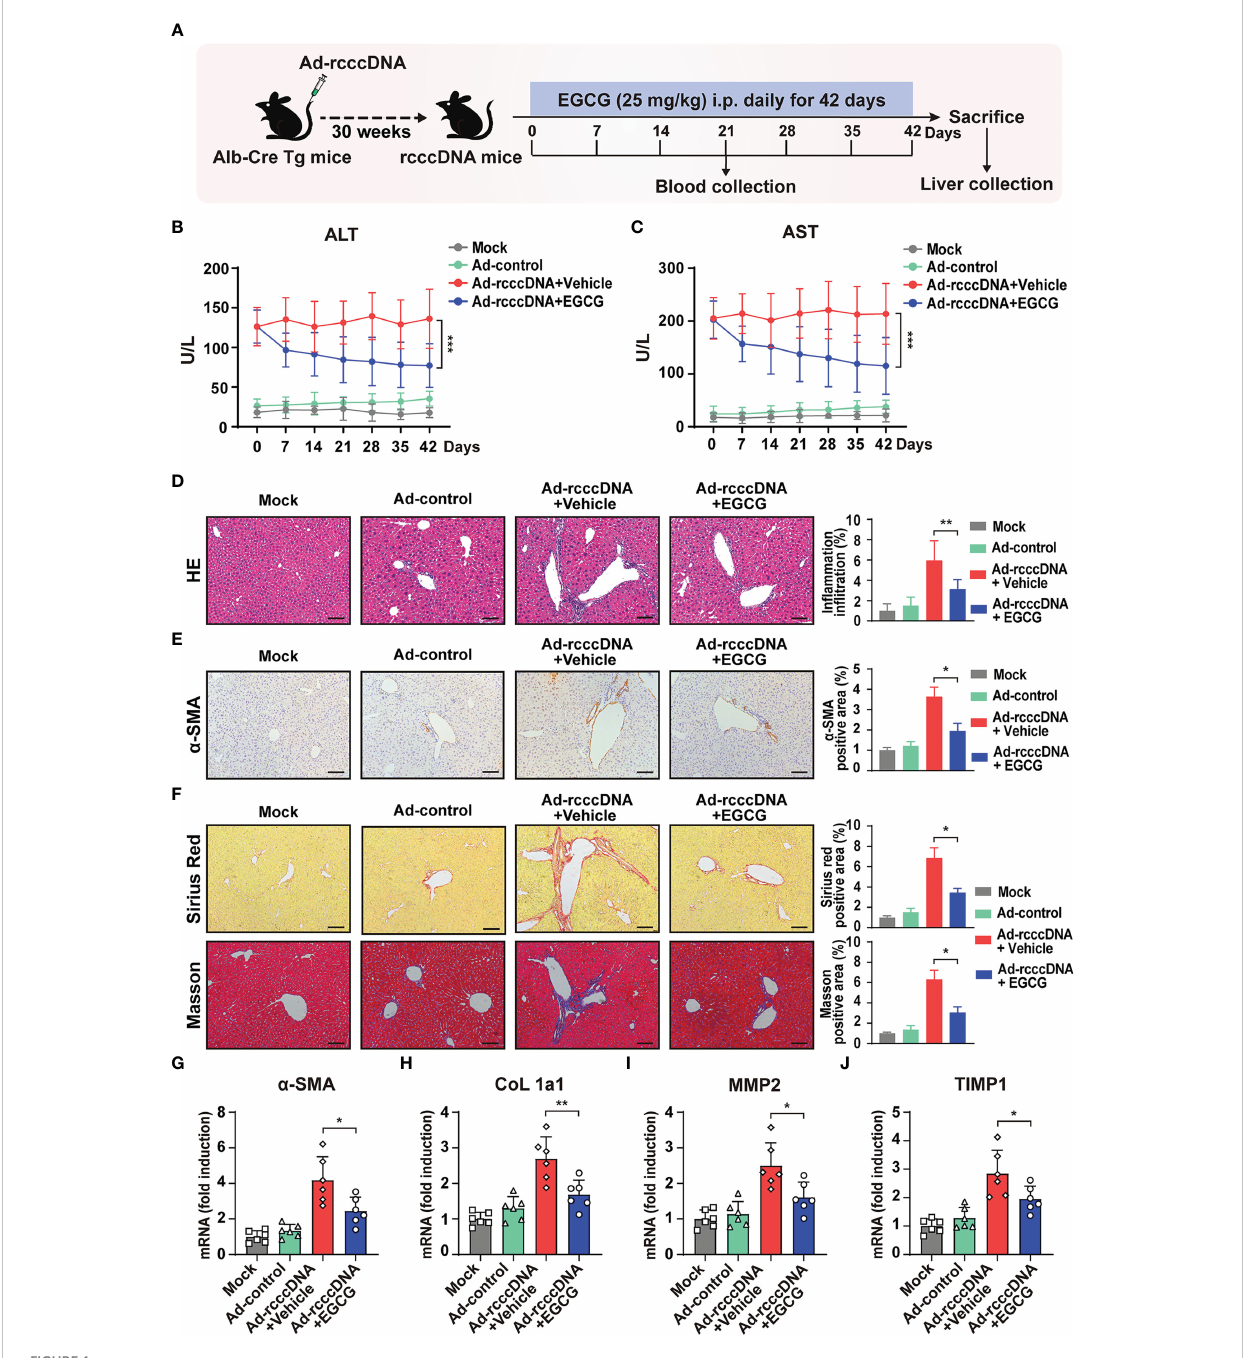
FIGURE 1 EGCG treatment alleviates HBV-induced liver injury and fi brosis. (A) Alb-Cre Tg mice were intravenously injected with Ad/rcccDNA at 1.5 × 10 9 PFU to establish an HBV-induced liver fi brosis mouse model, and the rcccDNA mice were then received an intraperitoneal injection of 25 mg/kg EGCG daily for 42 days ( n = 6 per group). (B, C) Levels of serum ALT and AST were determined by ELISA. (D) Liver in fl ammation in fi ltration was detected by hematoxylin and eosin (H, E) staining. (E, F) a -SMA expression was determined by immunohistochemical staining with DAB (brown), and liver collagen deposition was determined by Sirius red staining and Masson ’ s trichrome staining. Quanti fi cation of a -SMA-, Sirius red- and Masson- positive areas were measured in 5 random fi elds of each slide using Image Pro-plus software. Scale bar: 100 m m. (G – J) The mRNA expression levels of a -SMA, CoL 1a1, MMP2 and TIMP were determined by qRT-PCR (normalized to GAPDH). Data are shown as mean ± SEM and compared by two- way analysis of variance (ANOVA) or unpaired Student ’ s t test. *P < 0.05, ** P < 0.01, *** P <